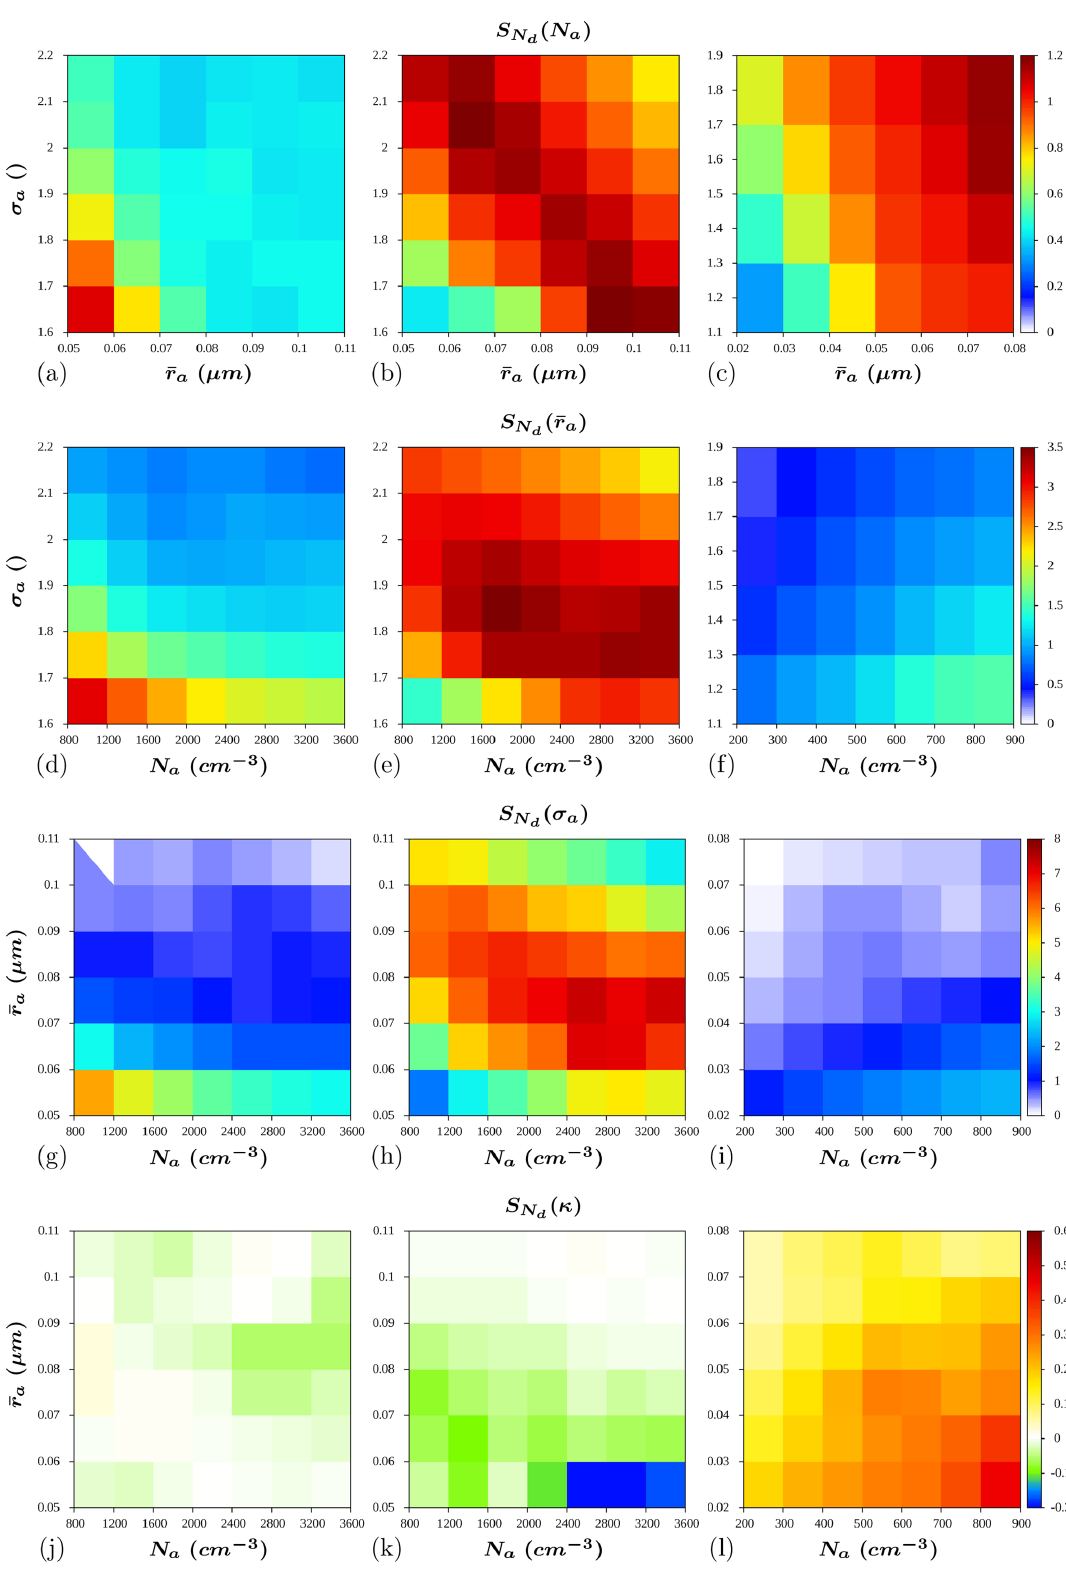
Figure 8. Sensitivity of N d to the aerosol properties in three different configurations of the model: with entrainment and bins for the aerosols (a, d, g, j) , without entrainment (b, e, h, k) and without bins for the aerosol (c, f, i, l)